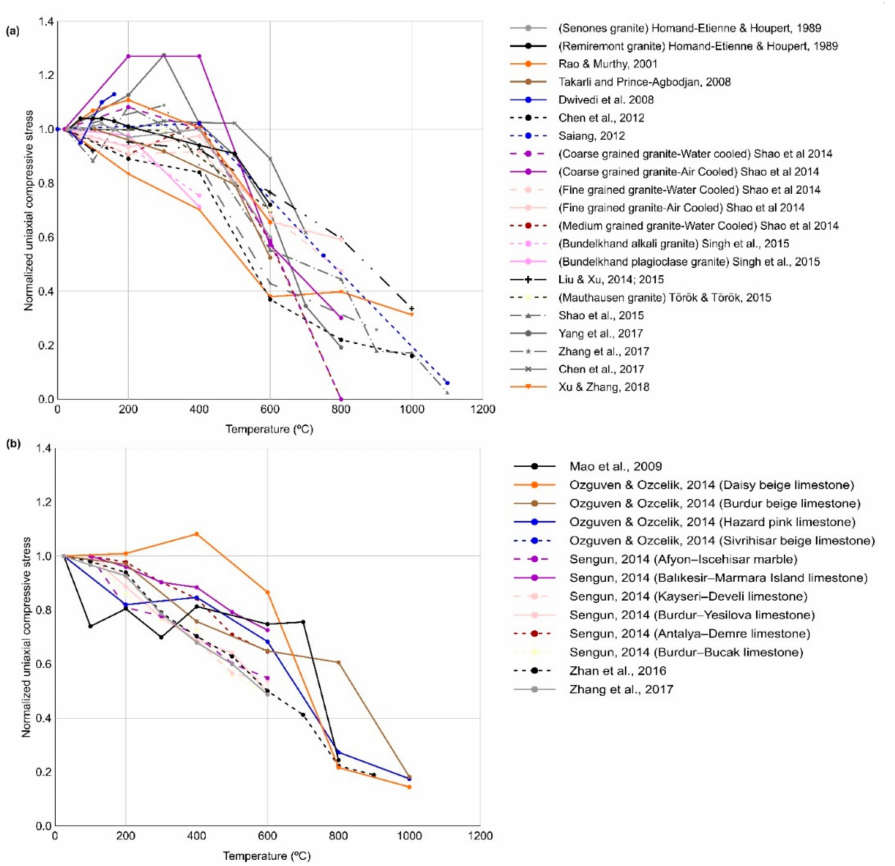
Figure 2. Variation of normalized uniaxial compressive strength of ( a ) granites and ( b ) limestones after thermal treatment. The plotted cases were compiled from scientific literature